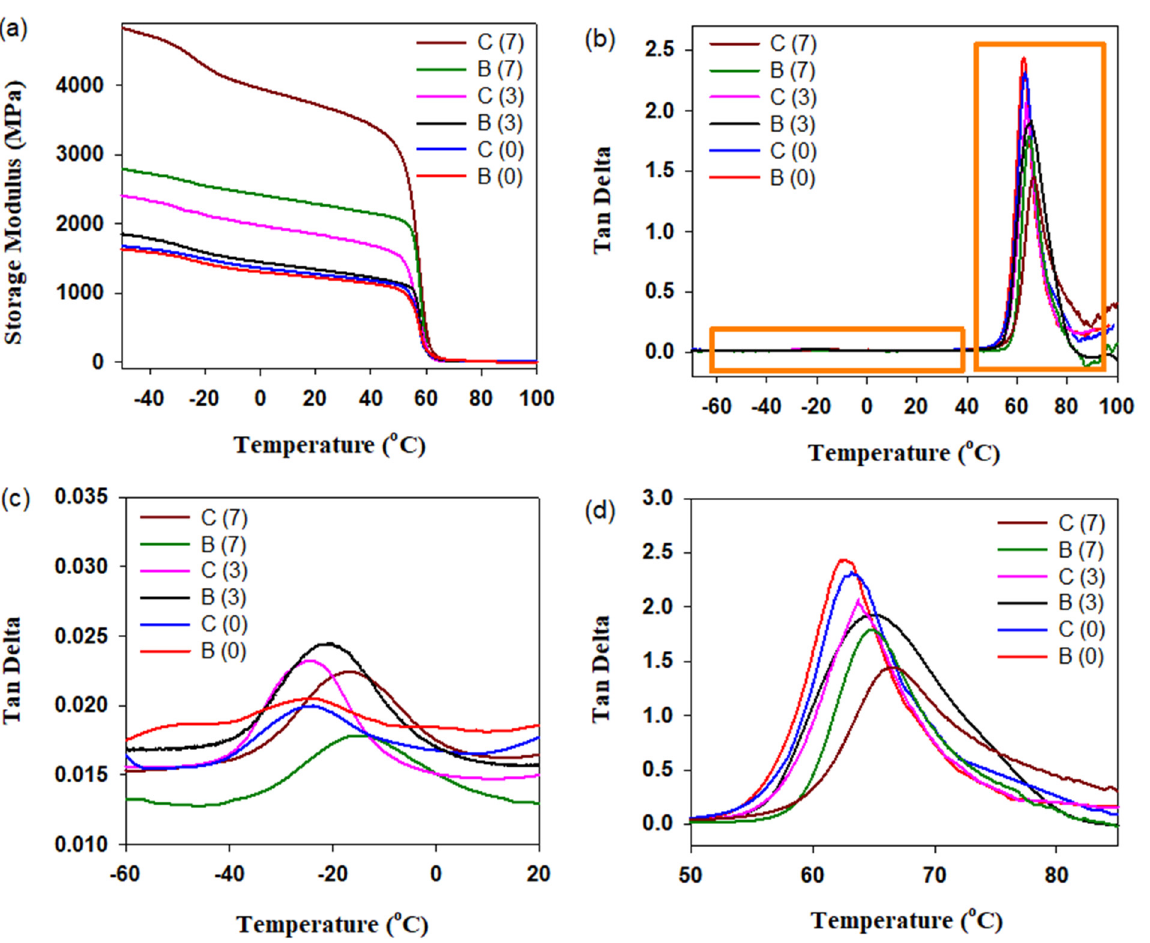
Figure 3. Storage modulus ( a ) and tan δ ( b – d ) of PLA/PBAT as well as PLA/PBAT/CNFs blends and in situ generated composites in a tensile mode. C and B stand for the composite and blend, respectively. The numbers in parentheses indicate the concentration of CNFs.